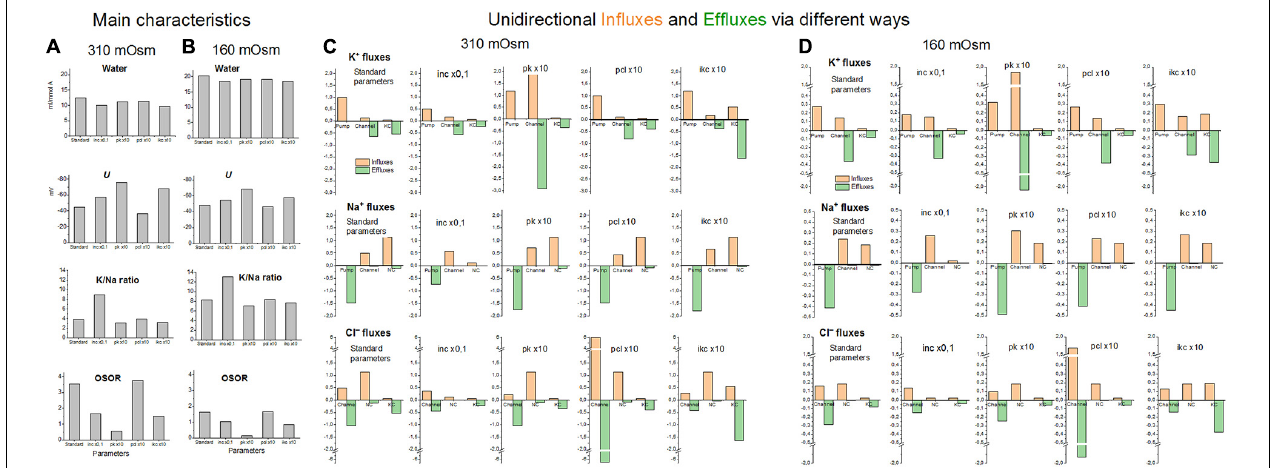
FIGURE 9 | The effects of a 10-fold decreasing or increasing membrane parameters on the main characteristics of ionic homeostasis and unidirectional fluxes via different ways under the balanced state in normal 310 mOsm medium and in the hypoosmolar medium of 160 mOsm with NaCl reduced by 75 mM. The calculation was carried out for the U937 cell model with a full set of cotransporters. The changed parameters are shown in the figure, the others remain unchanged and are presented in Table 2 , cells B , NC + KC + NKCC. Unidirectional flows via NKCC are not shown because they are small (see Table 4